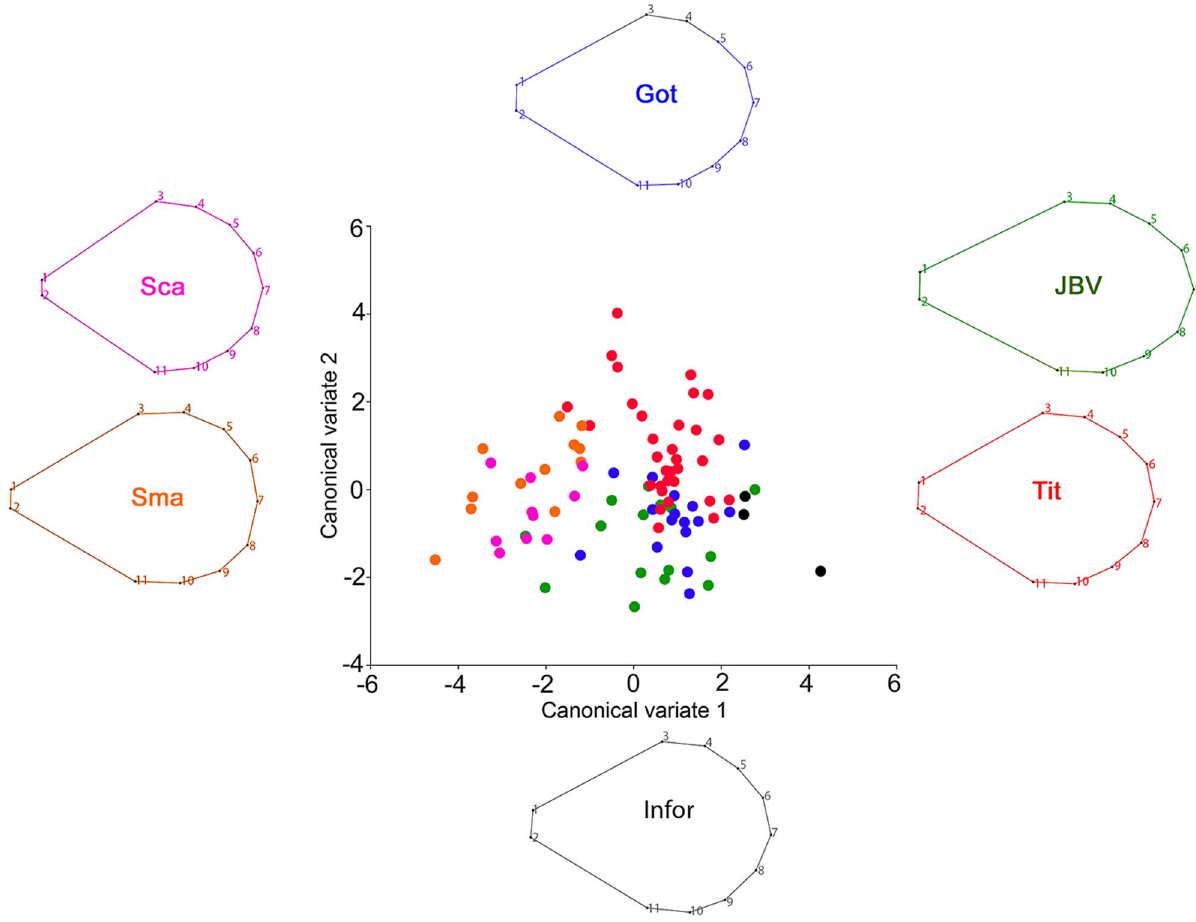
Fig. 3. Canonical variate analysis of the standard comparing the different Sophora toromiro lines and the two out-groups, Goteborg (Got), INFOR, Jardin Botanico Vin˜a (JBV), Titze (Tit), Sophora macrocarpa (Sma), Sophora cassioides (Sca). The wireframe represents the average shape of each one of the analyzed